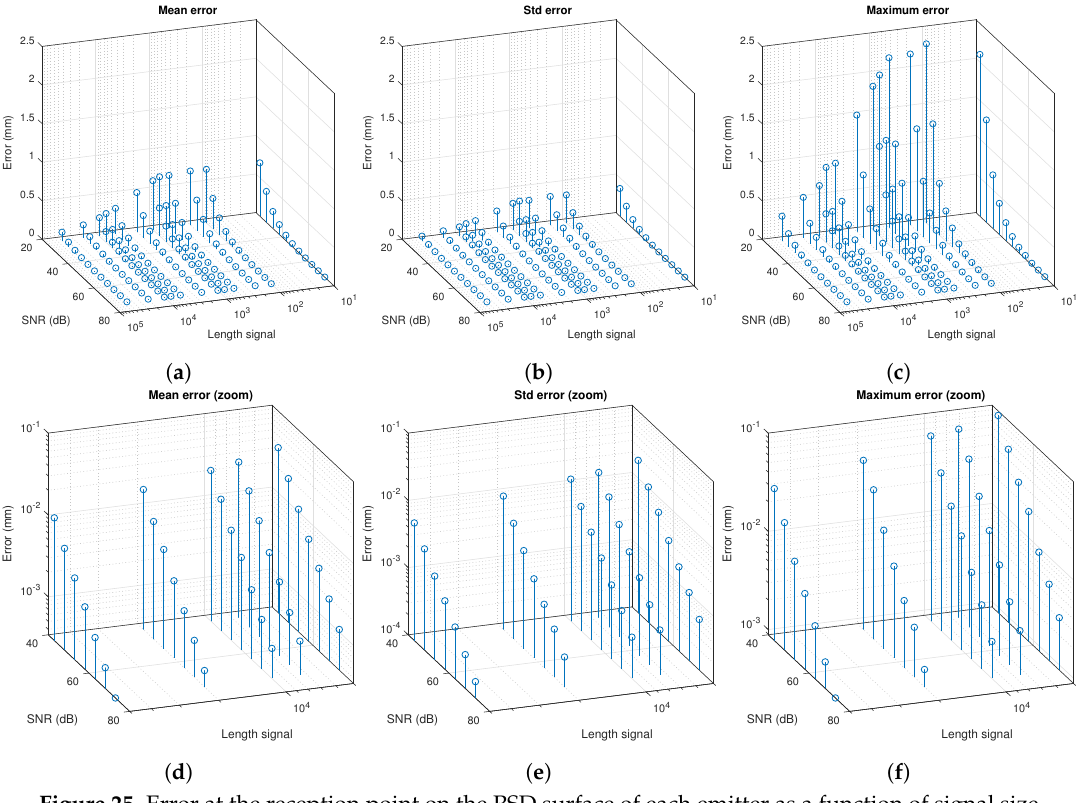
Figure 25. Error at the reception point on the PSD surface of each emitter as a function of signal size and RMS value: ( a ) mean value; ( b ) standard deviation; and ( c ) maximum value. Extended error area between 5000 and 50,000 samples and between 43 and 73 dB with the error axis in logarithmic scale: ( d ) mean value; ( e ) standard deviation; and ( f ) maximum value.